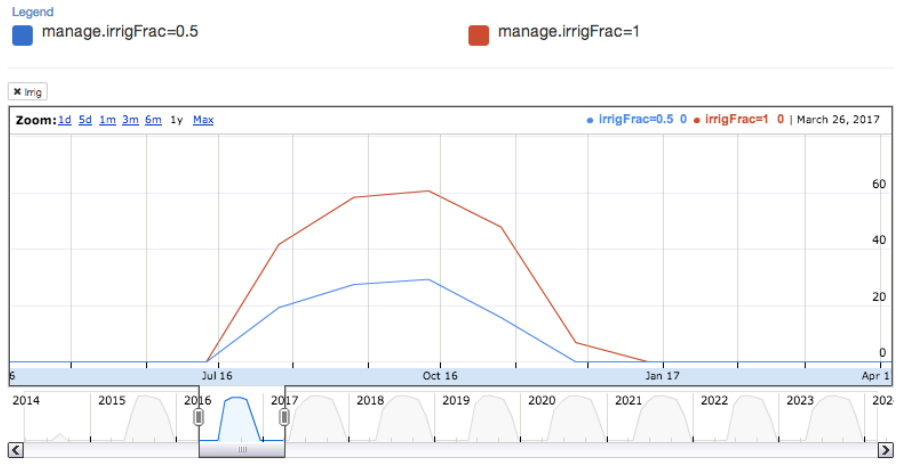
Figure 3. Biomass yields with irrigation set to half and full irrigation based on crop water needs.